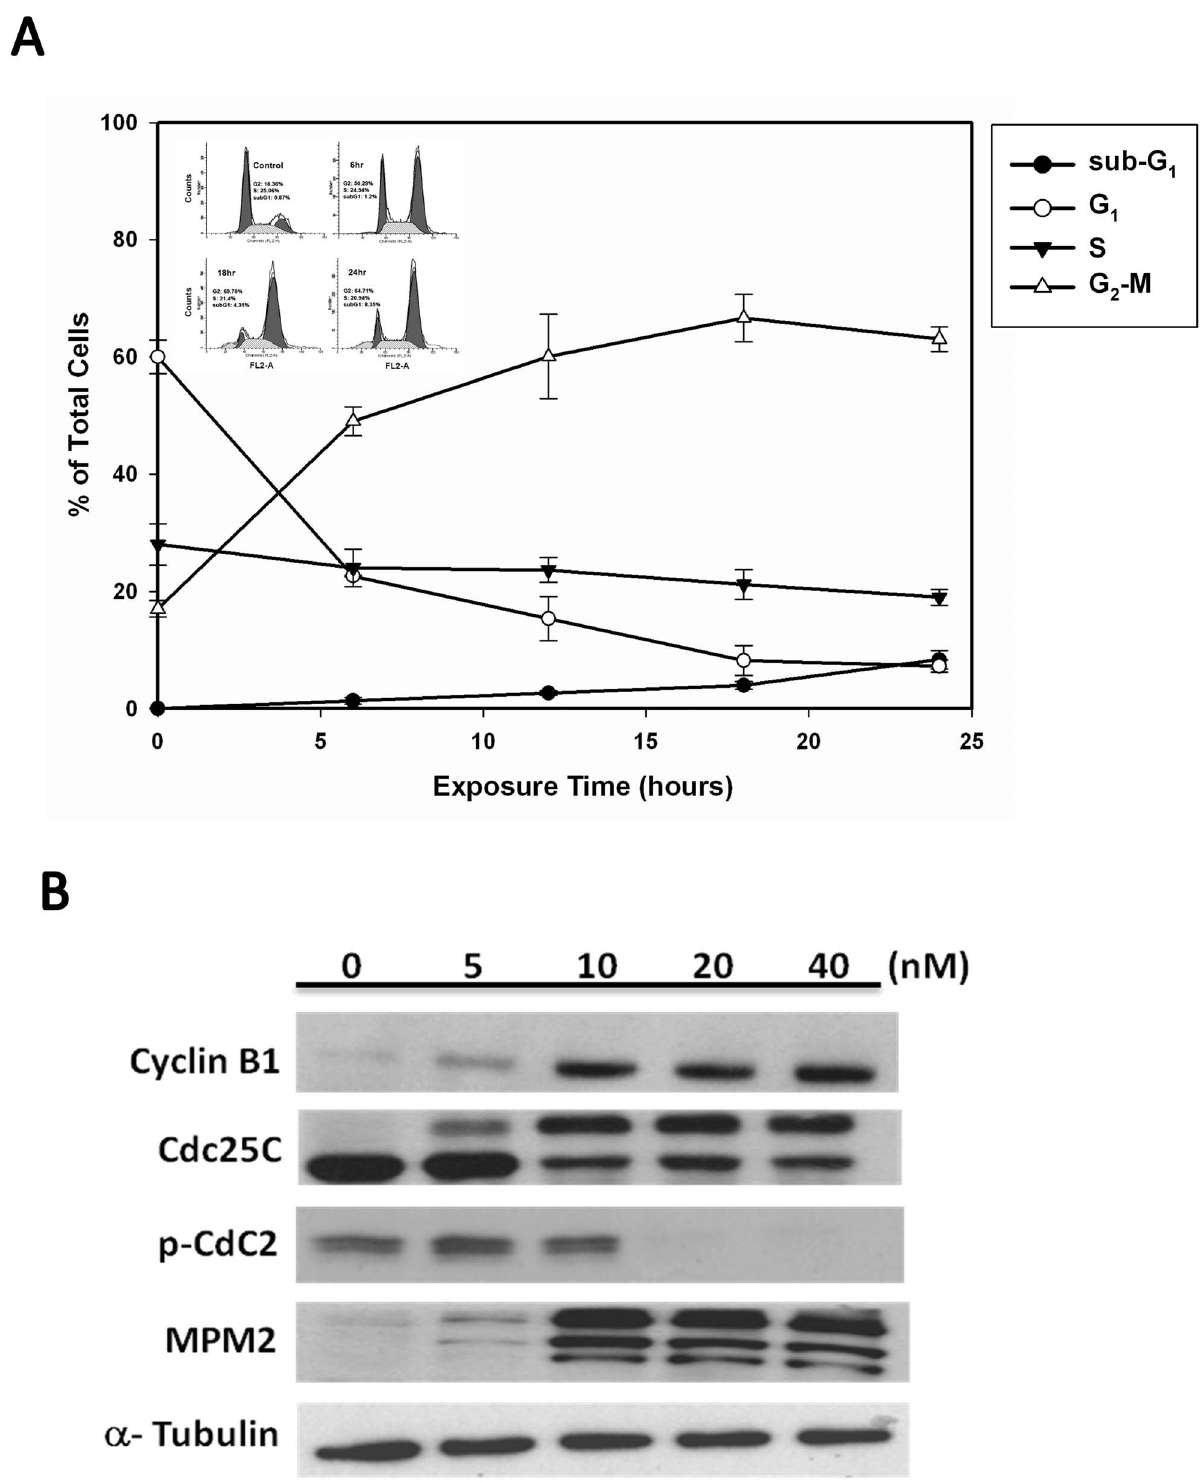
Figure 3. MPT0B214 induces G 2 -M phase arrest and change in the expressed and phosphorylated status of G 2 -M regulators, followed by cell apoptosis in KB cells. (A) The time effect of MPT0B214 on cell cycle distribution in KB cells (inserted figure: DNA histogram). Cells were treated with 10 nM MPT0B214 for different time points and analyzed for PI-stained DNA content by flow cytometry (B) Change in the expressed phosphorylated status of G 2 -M regulators under treatment. Cells are harvested after MPT0B214 treatment for 24 h, and the cell extract was prepared and loaded on SDS-PAGE. After electrophoresis, proteins were transferred to blots and probed with cyclin B1, Cdc25C, pCdc2, MPM2, and an internal control, a -tubulin antibodies.